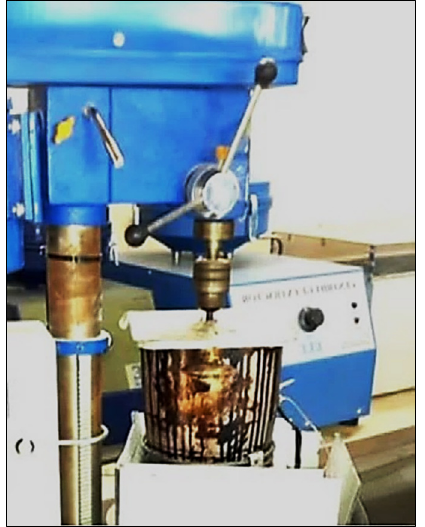
Figure 13. Blending process.